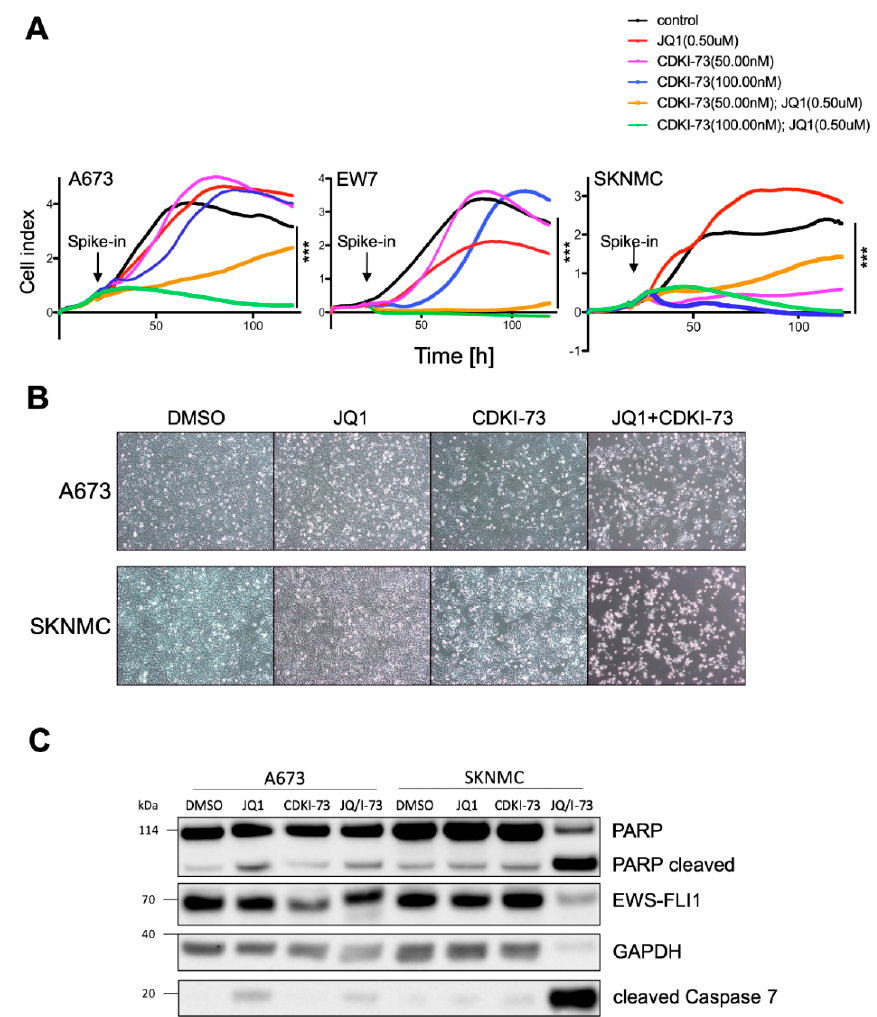
Figure 4. Combined targeting of CDK9 and BRD4 results in the inhibition of proliferation and induction of apoptosis. ( A ) Anti-proliferative activity of JQ1 and/or CDKI-73 against A673, EW7 and SKNMC cells by xCELLigence assay measuring cellular impedance every 4 h (relative cell index). Data are mean ± SEM (hexaplicates / group); 1-way ANOVA; *** p -value < 0.0005. ( B ) Phase contrast microscopy (magnification 10 × ) of cells 48 h after treatment with inhibitors. A673 or SKNMC cells were treated for 48 h with either 500 nM JQ1, 100 nM CDKI-73, or both, compared to DMSO control. ( C ) Western blot analysis of apoptosis susceptibility after JQ1 and / or CDKI-73 (I-73) treatment, respectively. Protein levels measured by antibodies against EWS-FLI1, PARP, CASP7, and GAPDH as loading control. A673 or SKNMC cells were treated for 24 h with inhibitors as